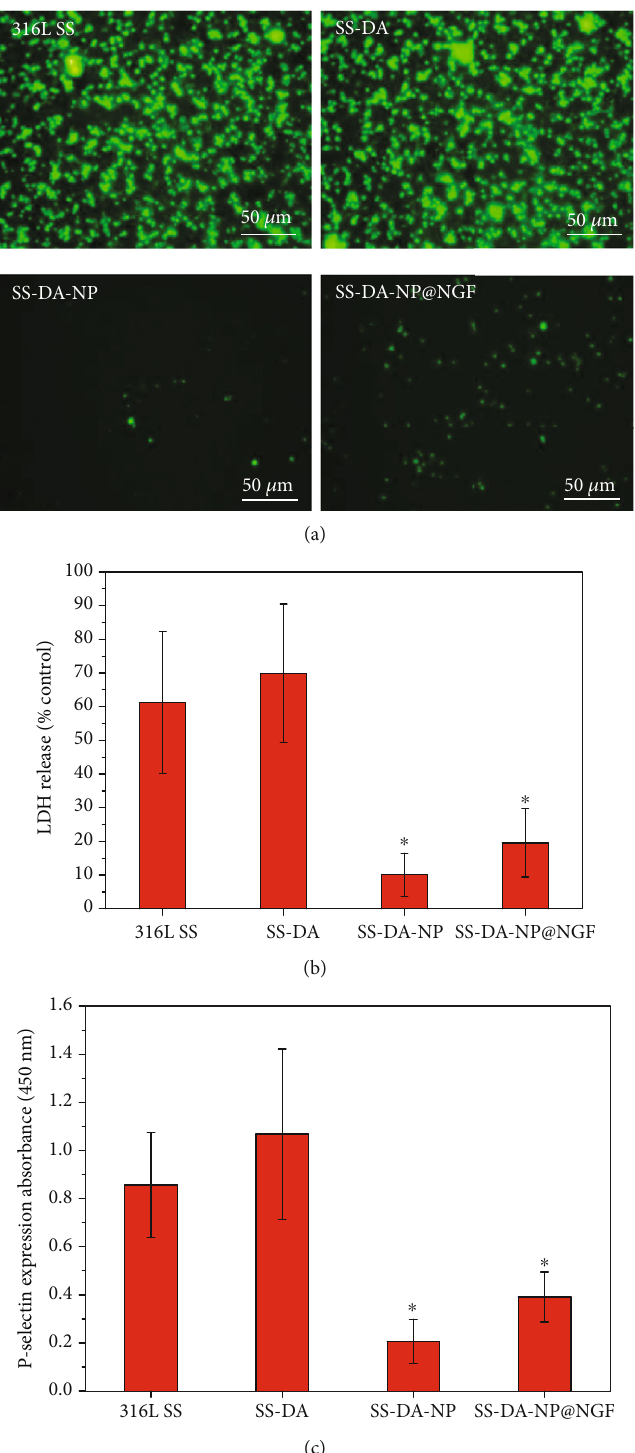
Figure 4: In vitro blood compatibility evaluation result. (a) Rhodamine 123 fl uorescence staining of adherent platelets, (b) LDH release, and (c) P-selectin expression level of platelets adhered on di ff erent sample surfaces ( mean ± SD , n = 6 , ∗ p < 0 : 05 indicates signi fi cant di ff erence compared to 316L SS and